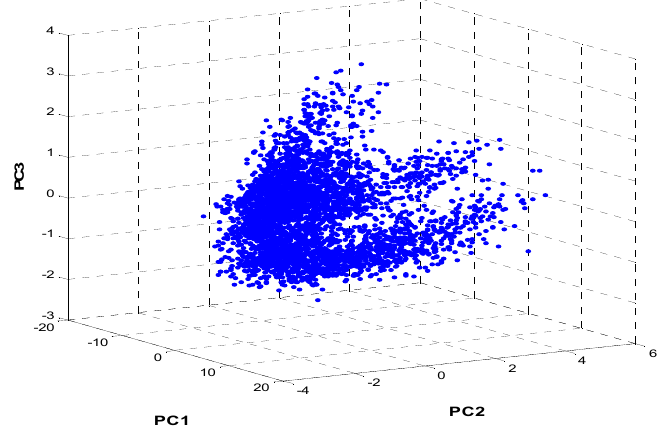
Figure 13. 3 ‐ Dimensional manifold after the PCA after dimension reduction of the original Figure 13. 3-Dimensional manifold after the PCA after dimension reduction of the original 24 ‐ dimensional space. 24-dimensional